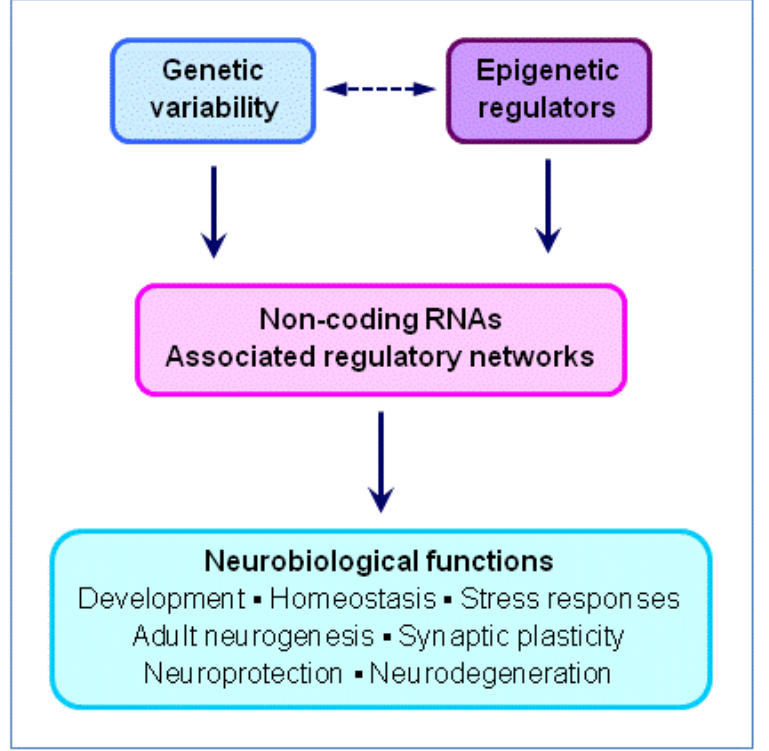
Figure 3. Regulation and neurobiological functions of non-coding